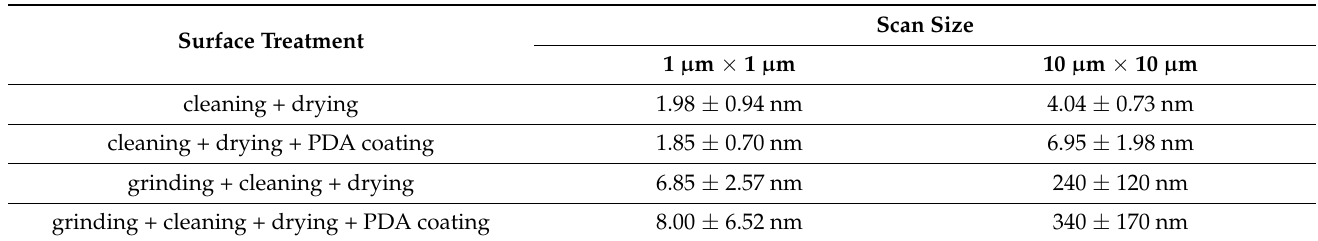
Table 5. The Sa roughness values of the PI-PLA samples exhibiting the highest adhesion force, including the reference sample after cleaning and drying.